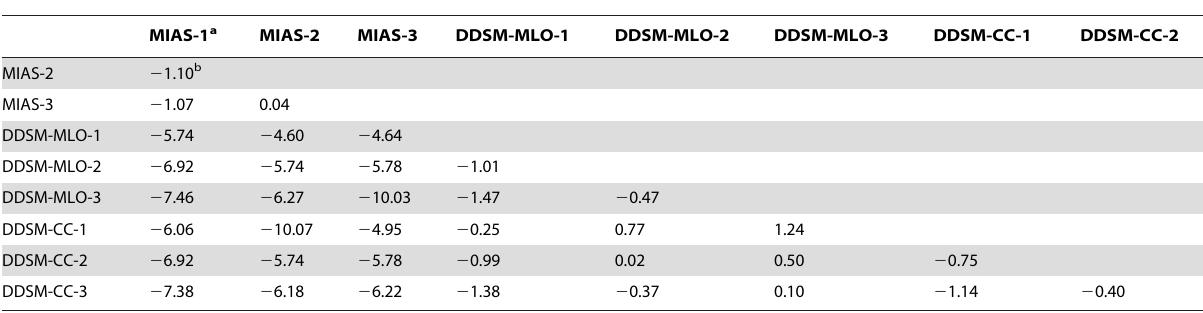
Table 3. Bayesian Classifier